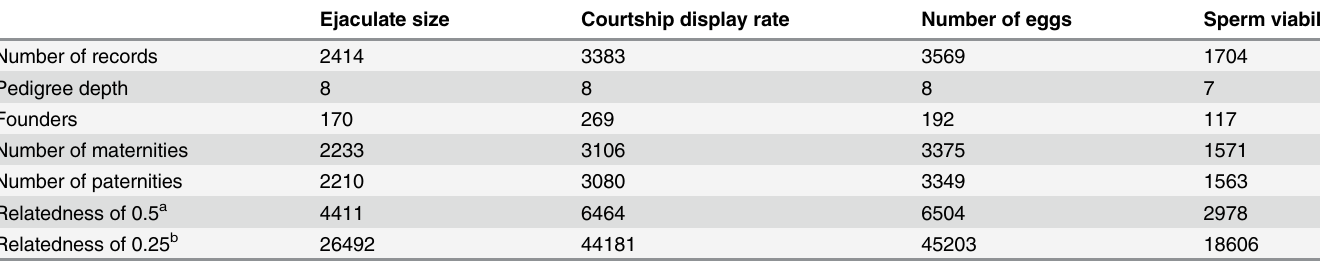
Table 1. Basic statistics describing the